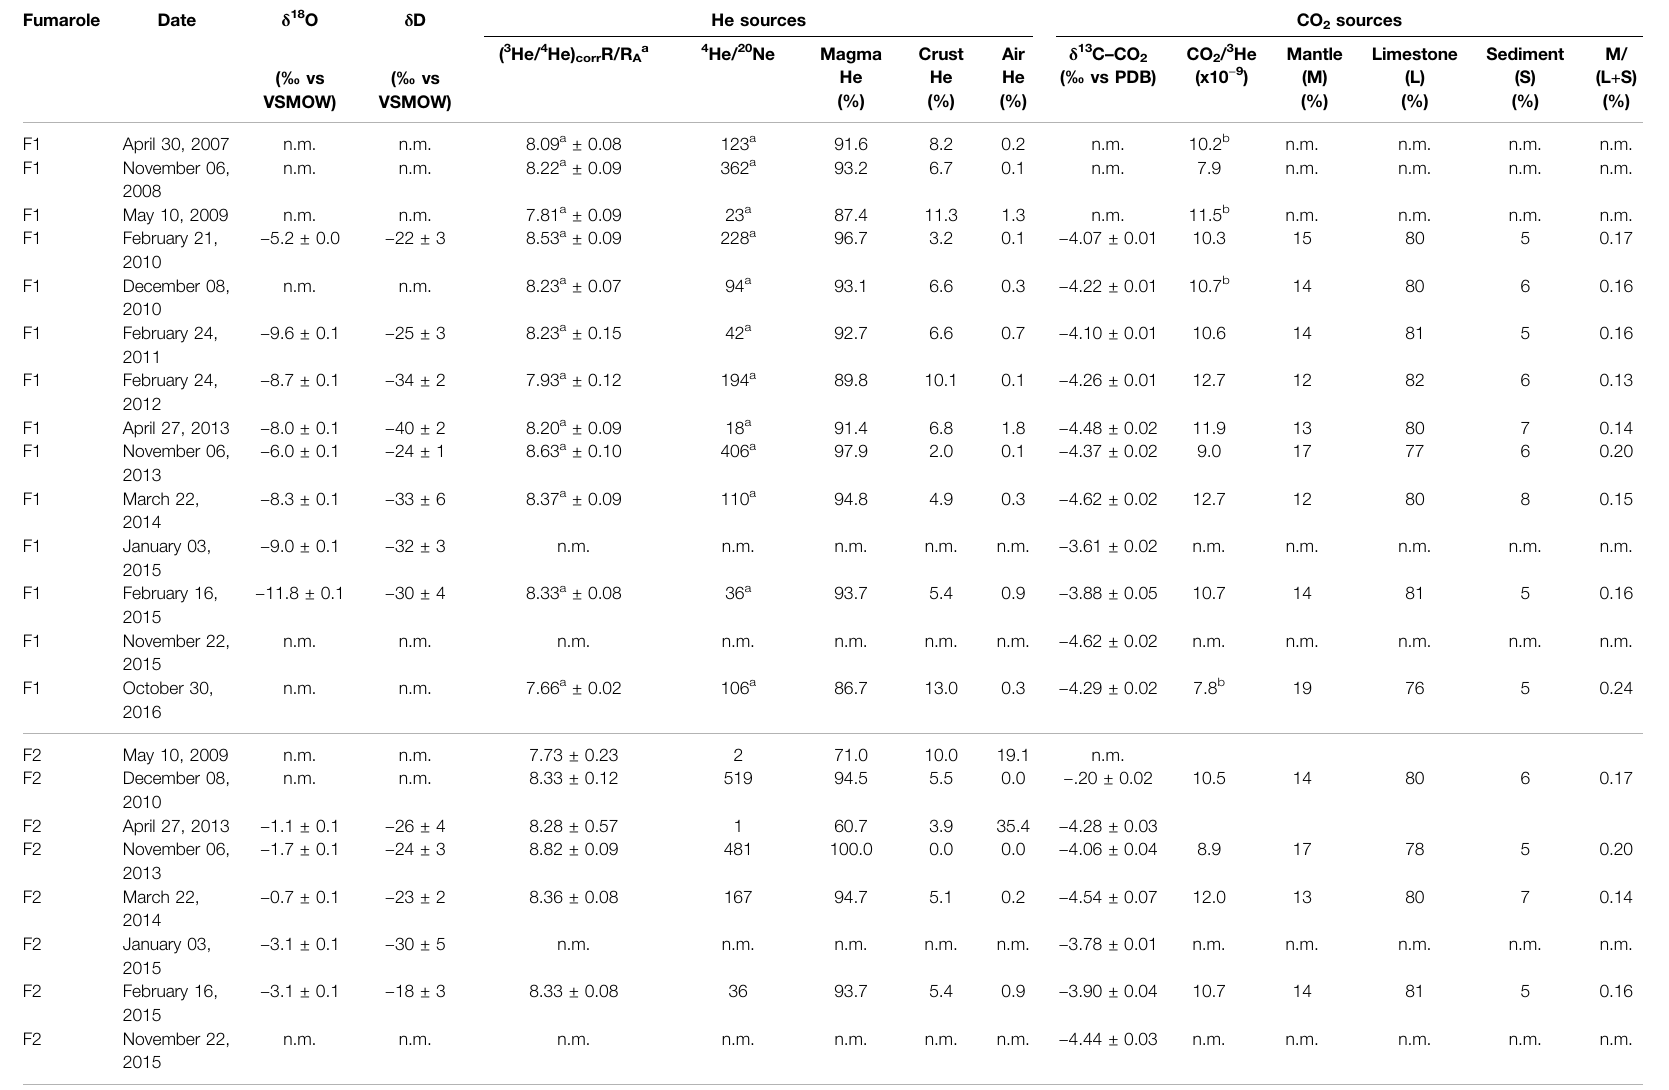
TABLE 2 | δ 18 O and δ 2 H isotope ratios ( ‰ vs.VSMOW) in fumarole condensates, air-corrected 3 He/ 4 He and 4 He/ 20 Ne ratios, and fraction of He source (air, magma and crust) in fumarole gas samples. δ 13 C-CO 2 ( ‰